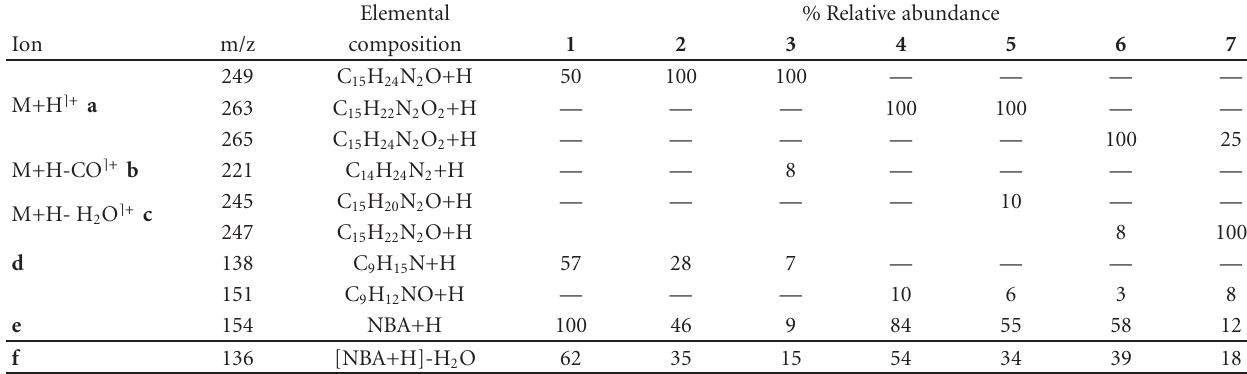
Table 1: Relative abundances of characteristic ions in the FAB mass spectra of 1 – 7 . Elemental % Relative abundance